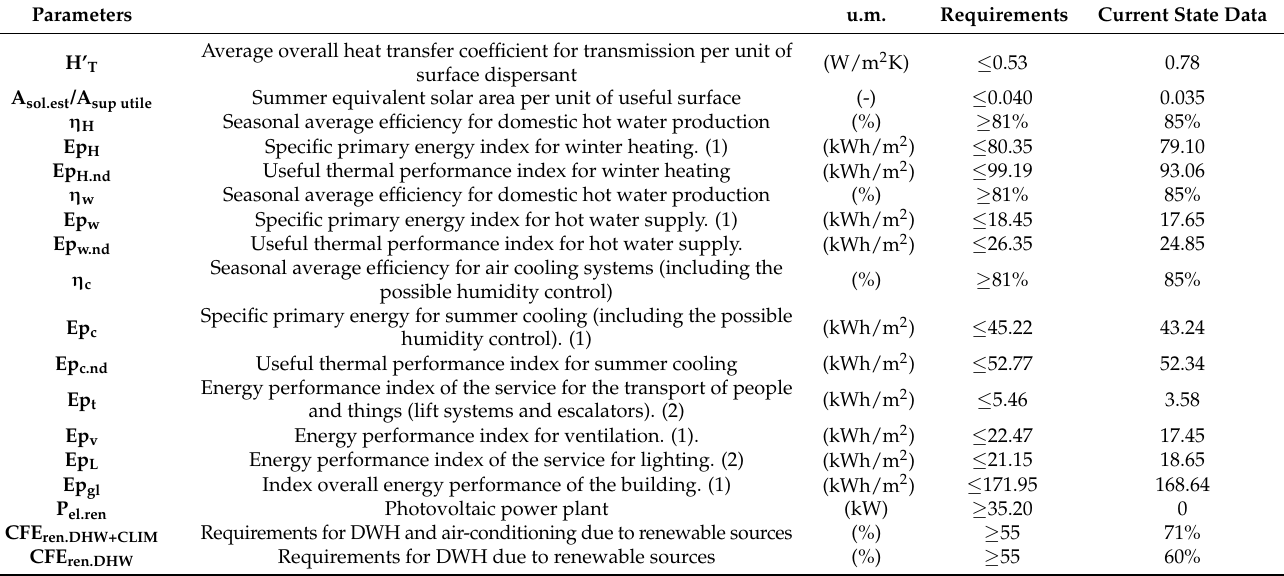
Table 8. nZEB parameters of the current